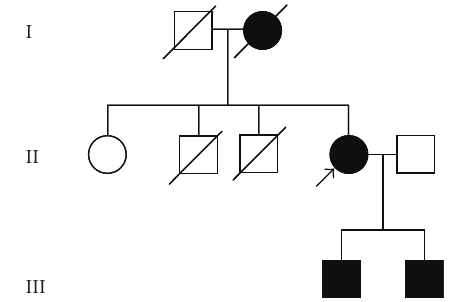
Figure 2: Pedigree showing a ff ected members with VHL. Open symbols , una ff ected subjects; solid symbols , a ff ected subjects; symbols with slashes , deceased members; and arrow ,